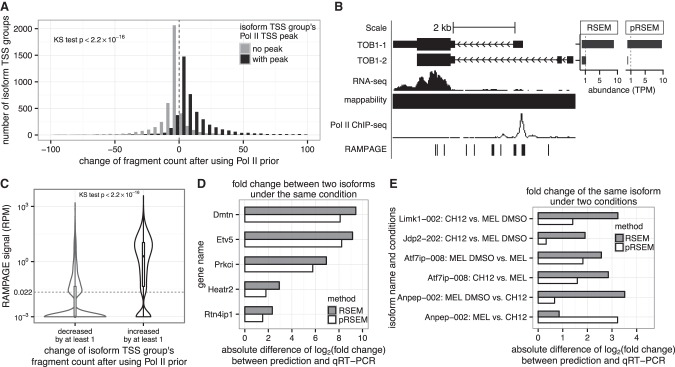
pRSEM more accurately allocates multimapping reads between isoforms. (A) Distributions of the change of fragment count between pRSEM and RSEM for isoform TSS groups with (black) and without (gray) Pol II TSS peaks. The two distributions are significantly different (P < 2.2 × 10−16, Kolmogorov-Smirnov test). (B) An example of multimapping read allocation. Shown are TOB1’s two protein-coding isoforms, mappability, RNA-seq signal, Pol II ChIP-seq signal, RAMPAGE signal, and estimated abundances from RSEM and pRSEM (top right). (C) Distributions of RAMPAGE signals for isoform TSS groups that have their fragment counts decreased by at least one (gray) or increased by at least one (black) after using a Pol II–informed prior. The dashed line denotes the signal corresponding to one RAMPAGE read. The two distributions are significantly different (P < 2.2 × 10−16, Kolmogorov-Smirnov test). A small fractional number (10−3) was added to the RAMPAGE signal for each isoform TSS group to allow display of zero signals on a log scale. Data shown in A through C are based on the K562 RNA-seq replicate one and RAMPAGE replicate one data sets. Isoform TSS groups in A and C are from genes that had “mixed” peak status and did not overlap or share reads with any other gene. Isoform TSS groups that were estimated to have abundance of less than one TPM according to both RSEM and pRSEM or that had fragment count changes between the two methods of less than one or larger than 100 were excluded. (D) Comparison of RSEM (gray) and pRSEM (white) estimated fold changes between a gene's two isoforms in the MEL cell line with fold changes measured by qRT-PCR. (E) Comparison of RSEM (gray) and pRSEM (white) estimated isoform fold changes between two conditions with fold changes measured by qRT-PCR.